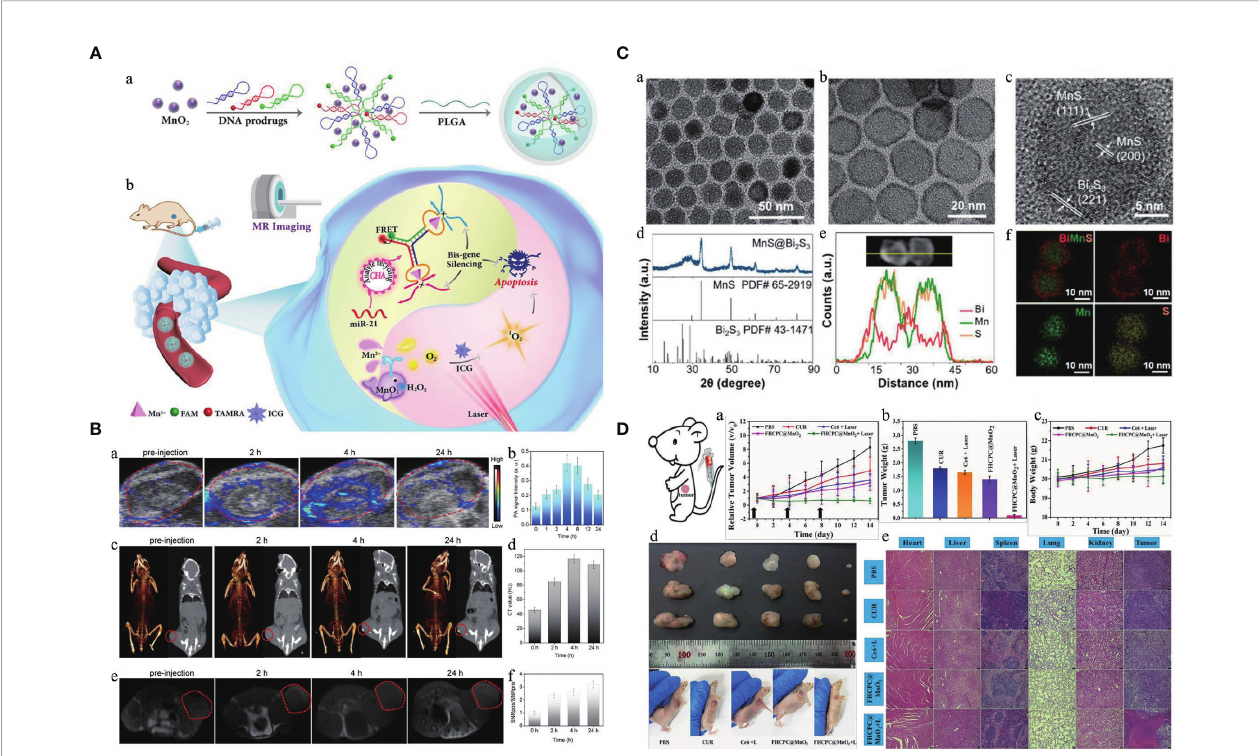
FIGURE 3 | Manganese (Mn)-based hybrid nanomaterials as theranostic agents and their application in tumor. (A) Schematic illustration of multifunctional nanocapsule and the systemic delivery of the self-suf fi cient theranostic nanoplatform (64). (B) Preparation and characterization of a core – shell MnS@Bi 2 S 3 - PEG nanostructure theranostic agents (70). (C) In vivo multimodal imaging (PA images, CT images, and MR images with the red circles mark the tumors) and corresponding signal analysis of tumor-bearing mice before and after intravenous injection of the monolayer bi-anchored Mn boride nanosheets (MBBN) (71). (D) In vivo therapeutic evaluation of FHCPC@MnO 2 nano fl owers (polyphosphazene coated onto Fe 3 O 4 nanoclusters, with MnO 2 nanosheets as outer shell). Scale bar = 75 m m (72). PA, photoacoustic; FHCPC, coating multifunctional polyphosphazenes onto Fe 3 O 4 nanoclusters and then growing manganese oxide nanosheets as outer shell; MBBN, Bi-anchored manganese boride